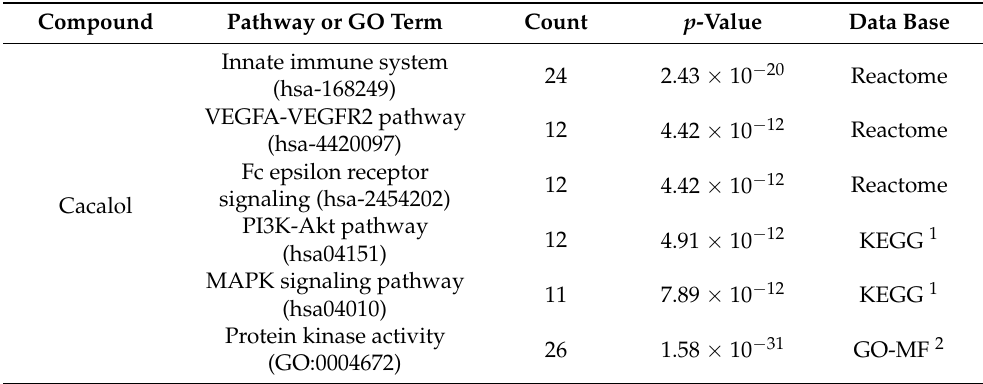
Table 2. Enrichment analysis (GO and Pathway) of the main 50 targets that interact with cacalol using network pharmacology approaches *.